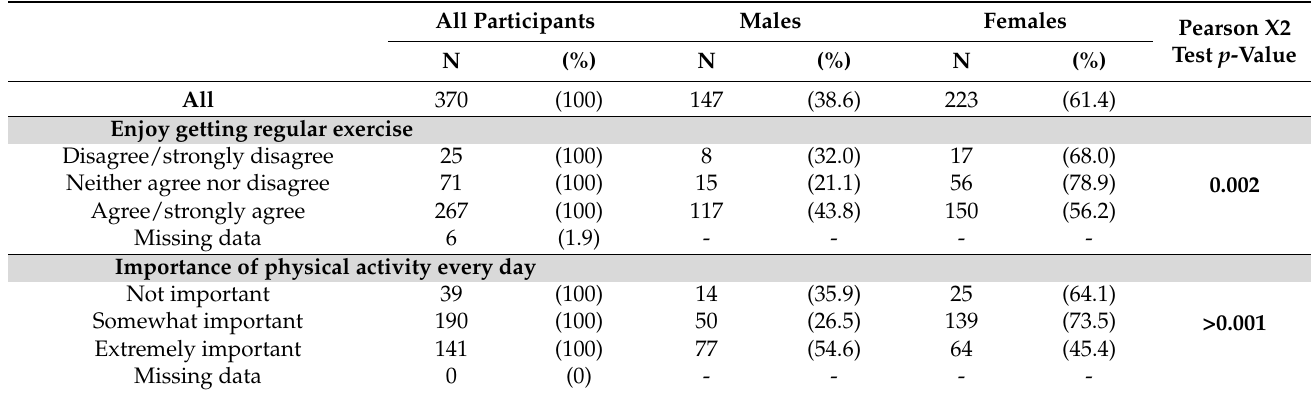
Table 3. Exploring collinearity between sex and other independent